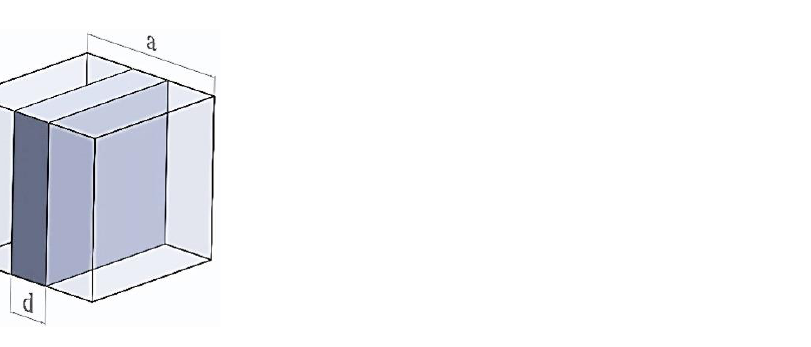
Figure 5. A cubic unit cell with an inclusion in the form of a plate (one-dimensional phononic crystal).